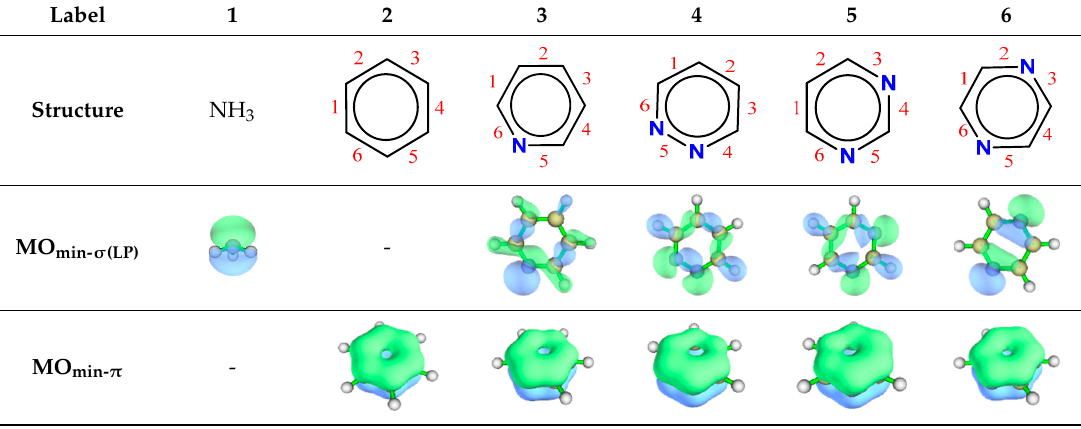
Table 1. Chemical structures of ammonia ( 1 ), benzene ( 2 ), six-membered nitrogen heterocycles ( 3 – 14 ), and five-membered nitrogen heterocycles ( 15 – 22 ). The isosurfaces (0.05) of the lowest σ MO containing nitrogen lone pair electrons ( MO min- σ (LP) ) and the lowest π MO ( MO min- π ) are presented for each of the 22 compounds.